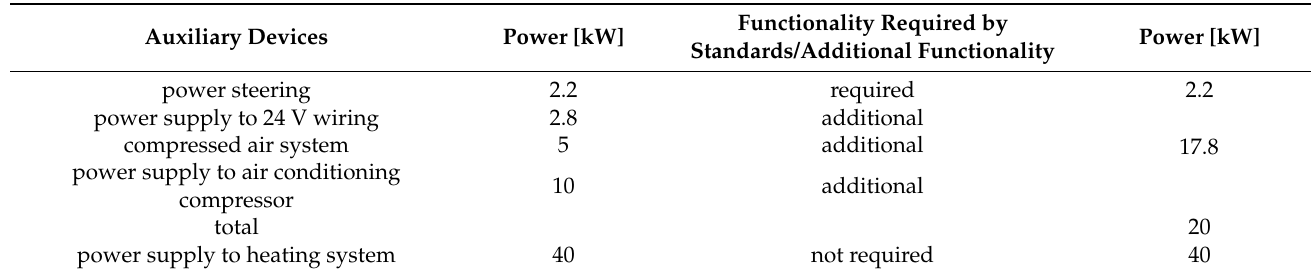
Table 2. Power of trolleybus auxiliary devices and requirements for maintaining power supply during passage through catenary insulators